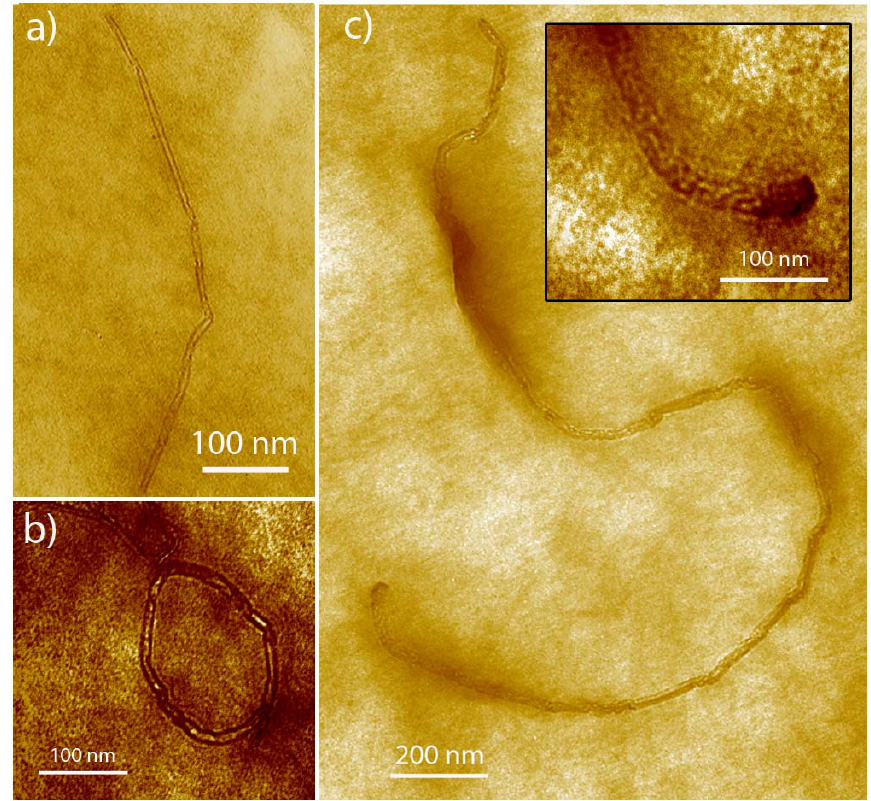
Figure 3. Transmission Electron Microscopy (TEM) images of P3HT/MWNTs suspended film. Darker zones, associated with thicker parts of the film, evidence the non-planar distribution of the nanotube